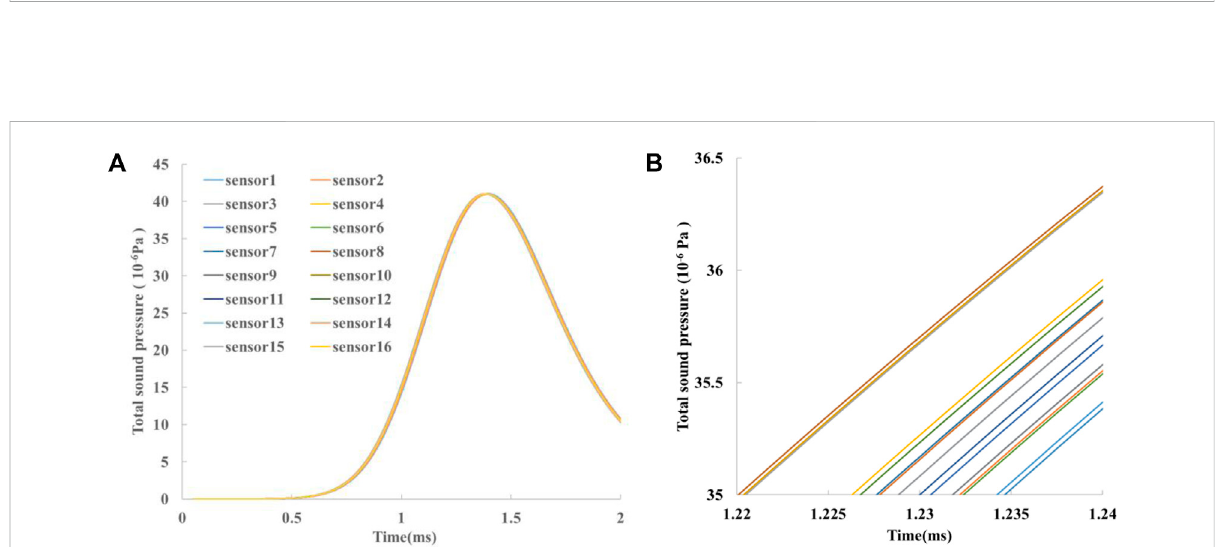
FIGURE 8 Simulation waveform and arrival time picking. (A) , Simulation waveform; (B) , Arrival time